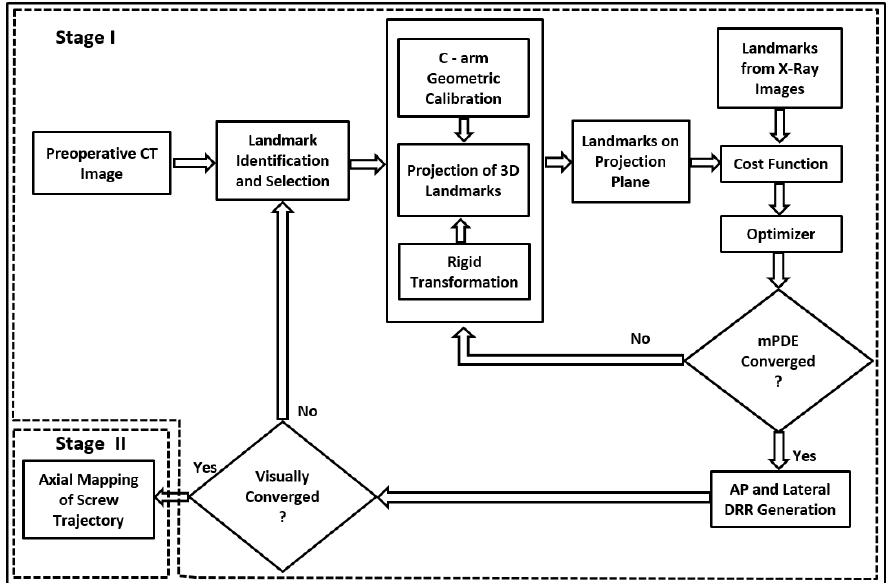
Figure 2. Workflow of hybrid ICP-DRR based 3D-2D registration framework for pedicle screw